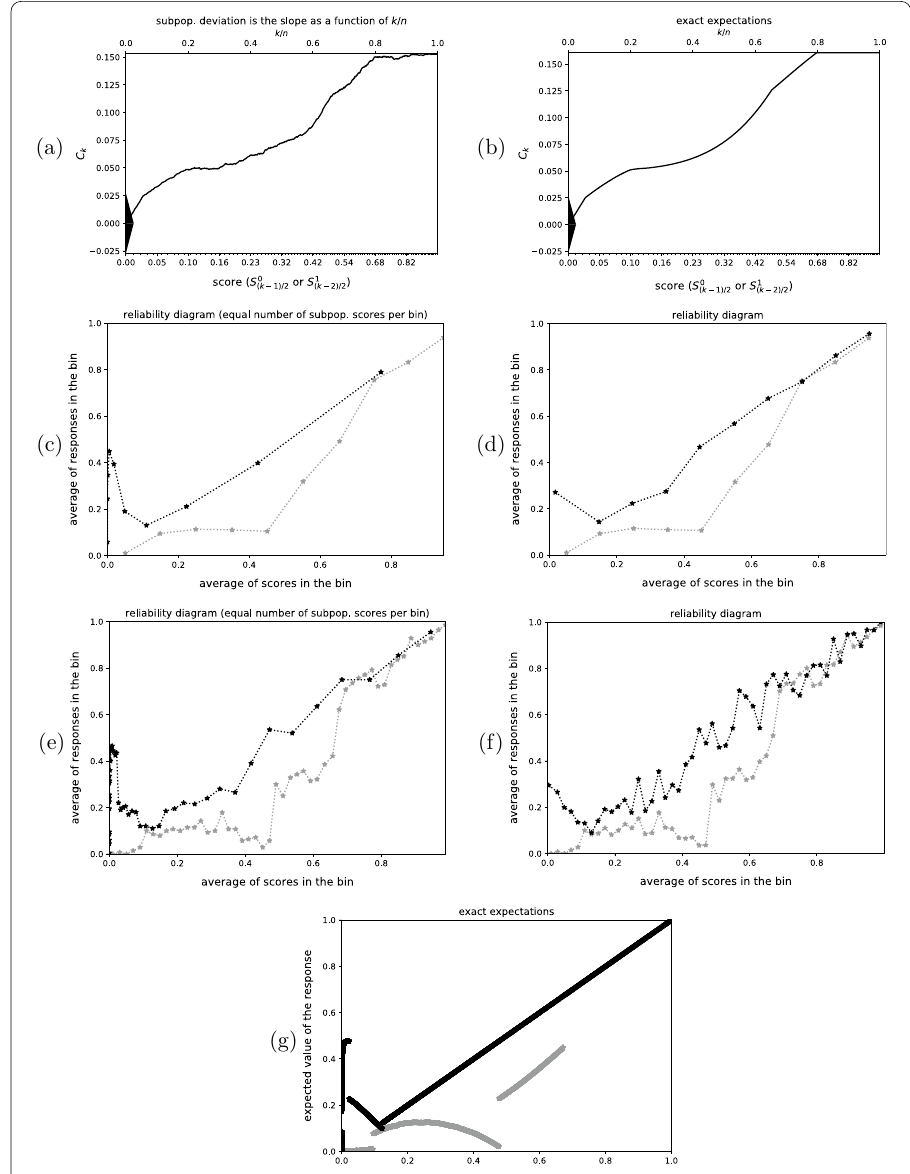
Fig. 4 n = 5472; Kuiper’s statistic is 0.1531 /σ = 11.32 , Kolmogorov’s and Smirnov’s is 0.1531 /σ = 11.32 ; the reliability diagrams all have trouble resolving the sharp behavior corresponding to the relatively sharp corners in the cumulative graphs ( a and b ), though the reliability diagram with 50 bins that has an equal number of subpopulation scores per bin ( e ) is decent. The metrics of Kuiper and of Kolmogorov and Smirnov report extremely statistically significant deviation, taking values of many times